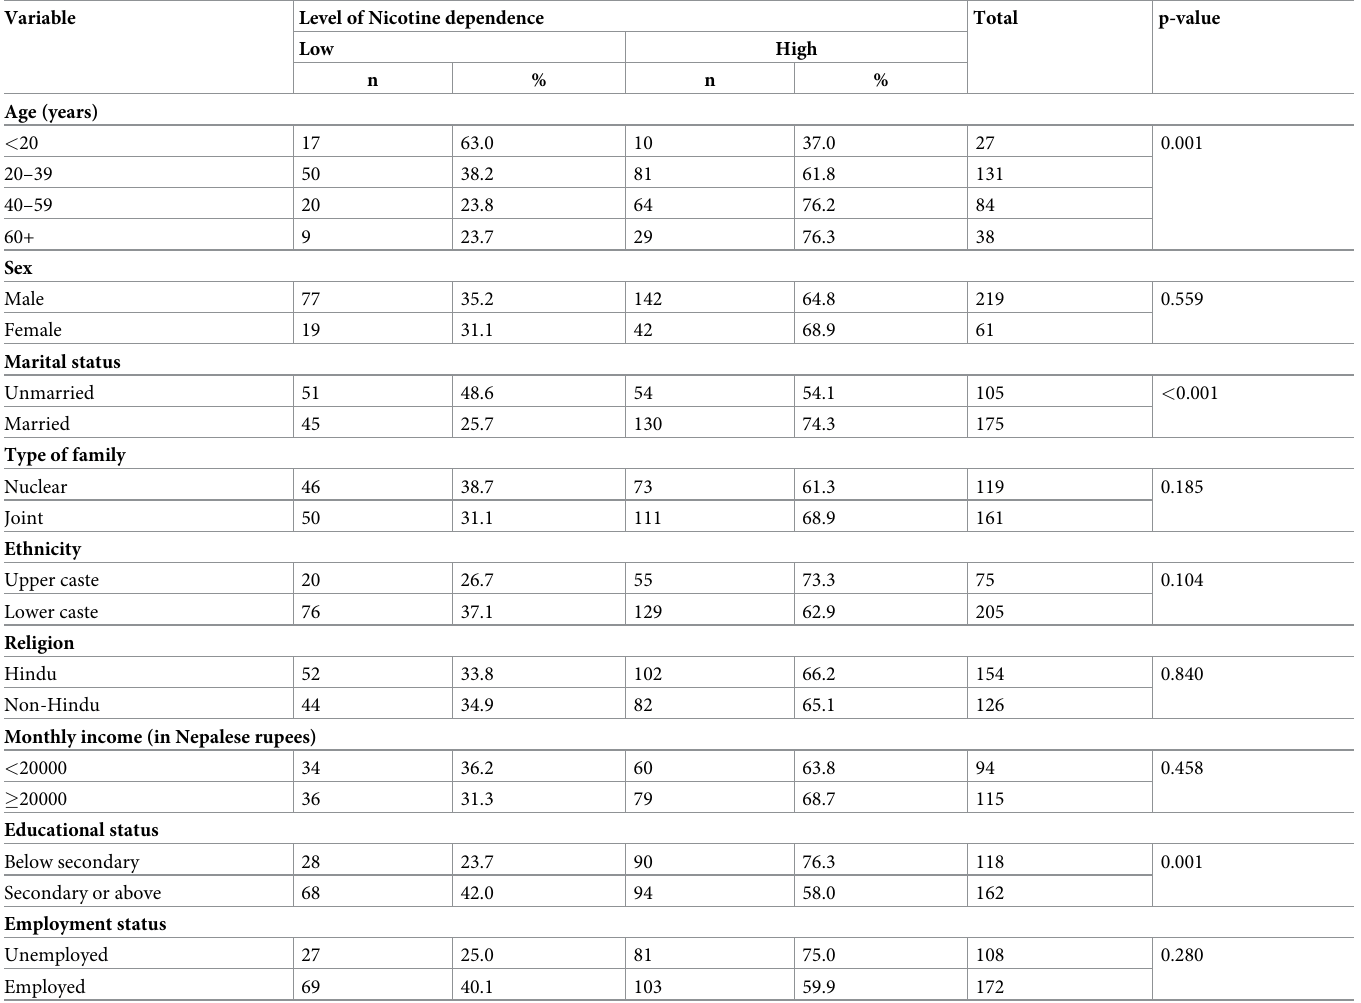
Table 3. Socio-demographic characteristic and nicotine